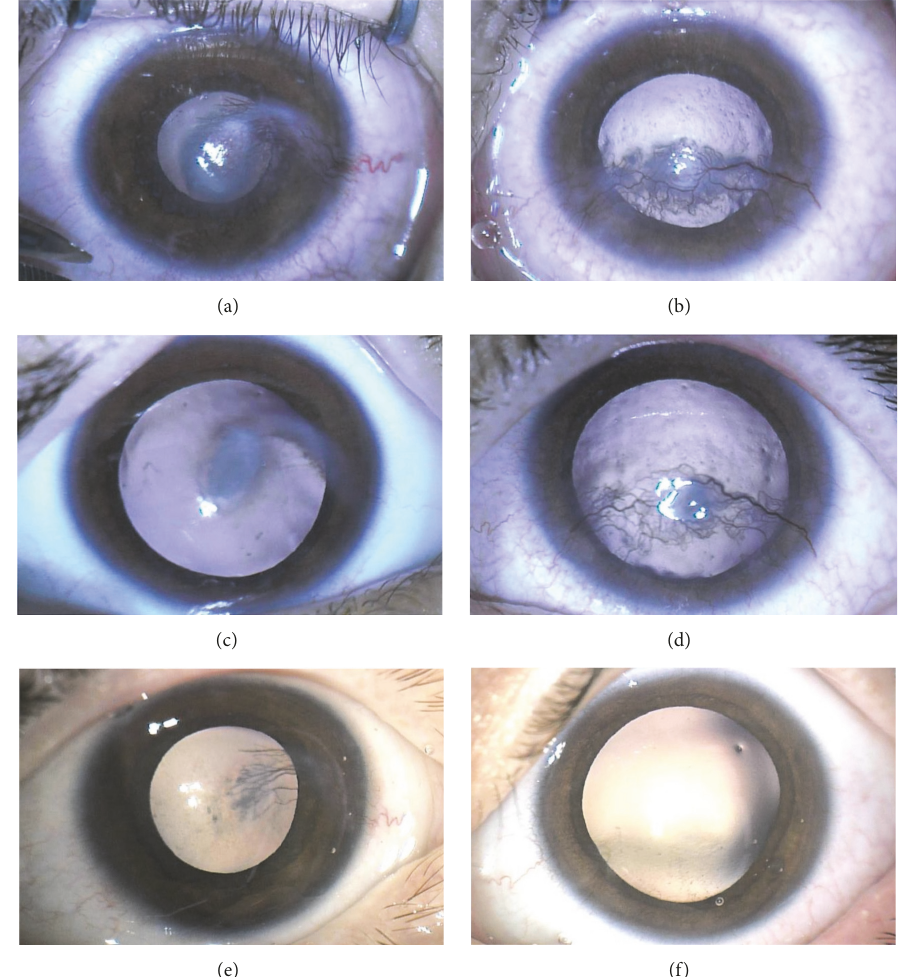
Figure 2: Photographs of Twin 2 with blepharokeratoconjunctivitis before and after treatment over an 8-month period. (a) Right cornea with stromal and epithelial vessels. (b) Left cornea with stromal and epithelial vessels. (c) Right cornea four weeks after subconjunctival triamcinoloneandbevacizumabinjectionsshowingregressingvessels.(d)Leftcorneainfour-weektimewithnoinjectionsshowingpersisting stromal and epithelial vessels and no observable benefit from systemic effect of bevacizumab. (e) Right cornea 8 months after subconjunctival triamcinolone and bevacizumab injections and 5 months after additional triamcinolone injections, with corneal scarring. (f) Left cornea 7 months after subconjunctival triamcinolone and bevacizumab injections and 5 months after additional triamcinolone injections, with corneal